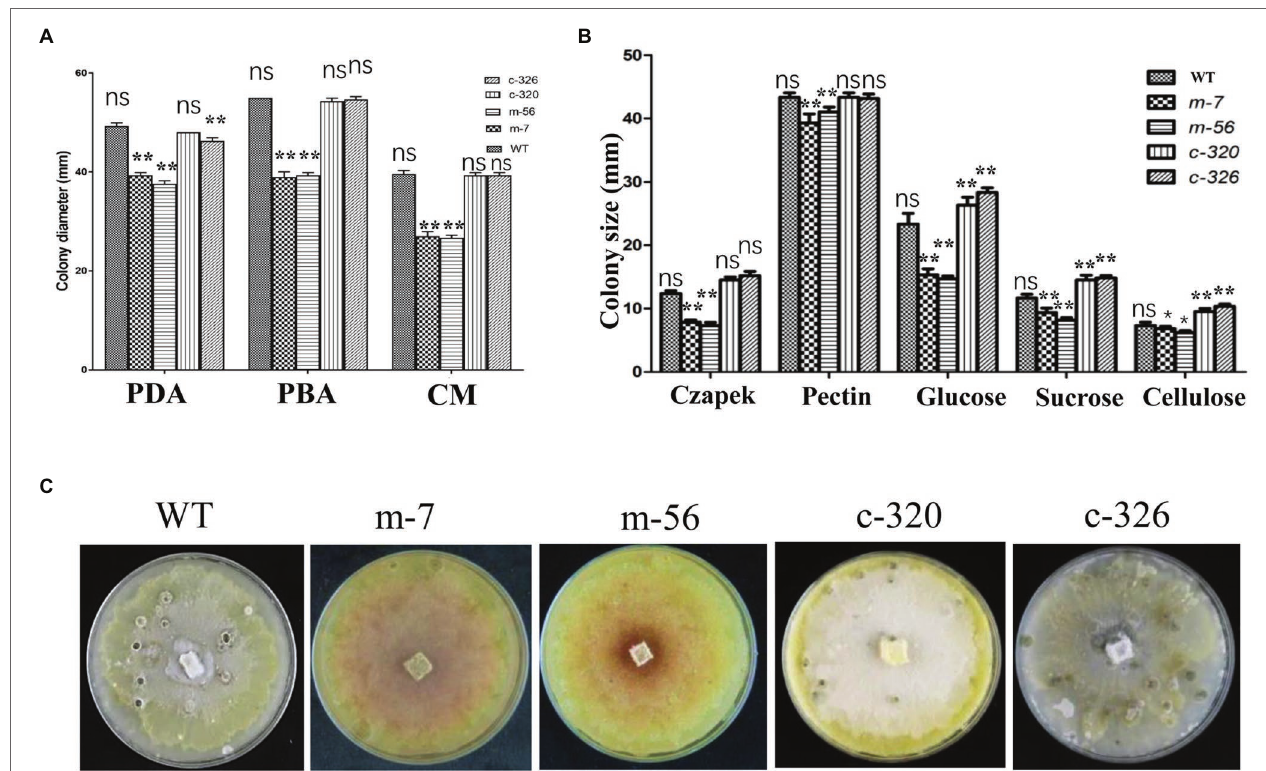
FIGURE 2 | Characterization of growth and development of the vpxlnR mutants. (A) Colony growth on potato dextrose agar (PDA), pear branch agar (PBA), and CM media. Mycelial agar plugs of wild-type (WT), vpxlnR mutants (m-7 and m-56), and VpxlnR complementation (C-320 and C-326) were placed on PDA, PBA, and CM media. Colony diameter was measured at 36 h, and images were captured at the same time. (B) Radial growth of WT, vpxlnR mutants , and complementation on carbon sources. Colony diameters were measured at 36 h. Czapek’s medium supplemented with glucose, sucrose, pectin, and cellulose, and Czapek only served as the control. The plates were incubated at 25 ° C in the dark for 48 h. Typical images of the colonies were captured at 36 h. (C) Fruiting body formation. Fruiting bodies were induced under 16-h light/8-h dark for 20 days on PDA medium. Each strain was cultured on three agar plates. Images were captured at 20 days. In the image, ns indicates a value of p > 0.05, * indicates a value of p < 0.05, ** indicates a value of p < 0.01, and the statistical analysis was performed using two-way